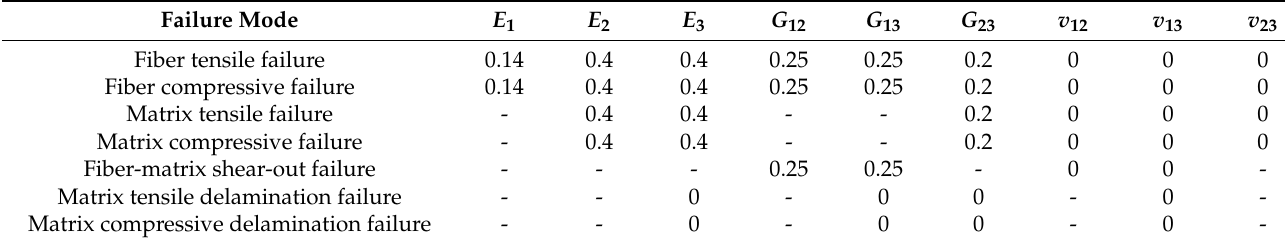
Table 2. Material parameter degradation per failure